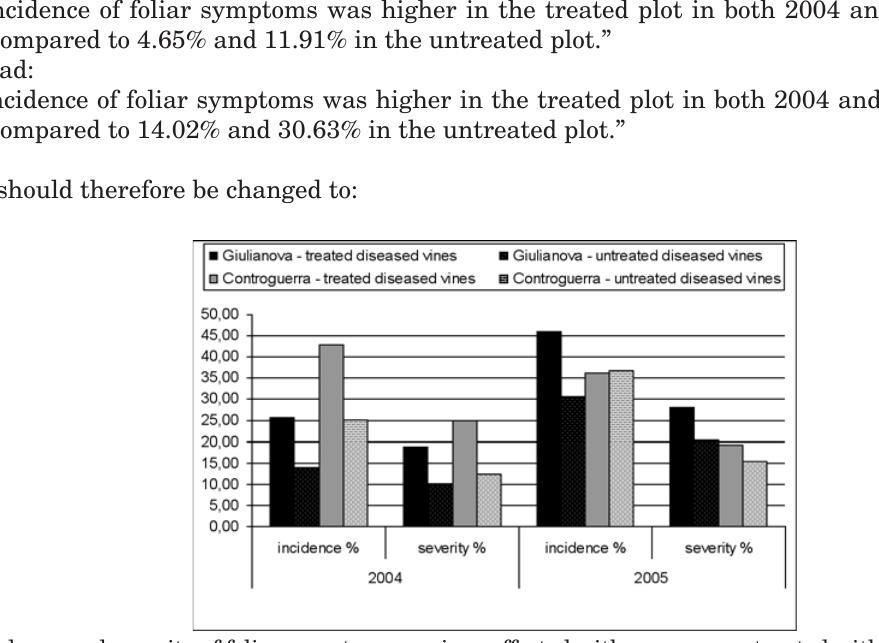
Fig. 2. Incidence and severity of foliar symptoms on vines affected with esca proper treated with nutrients and bioac- tivators, and untreated